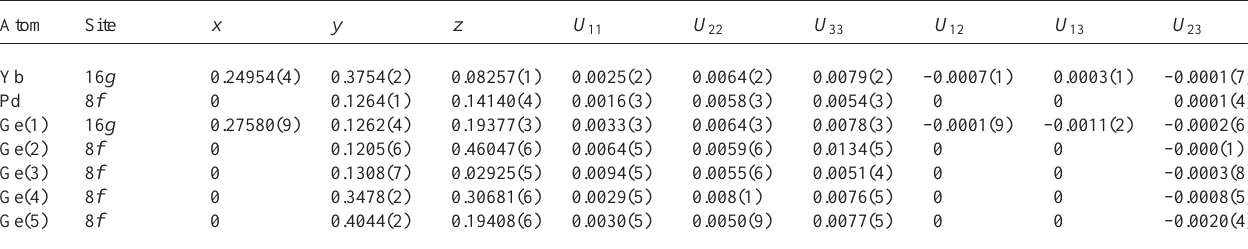
Table 2. Atomic coordinates and displacement parameters (in Å 2 )